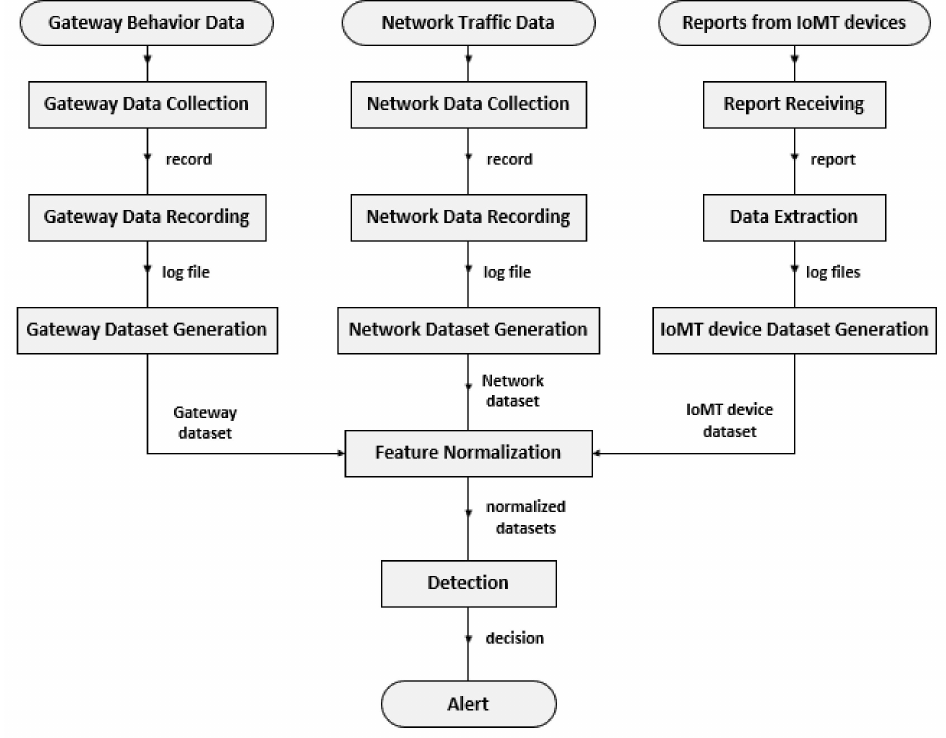
Figure 5. The central detection (CD) component.